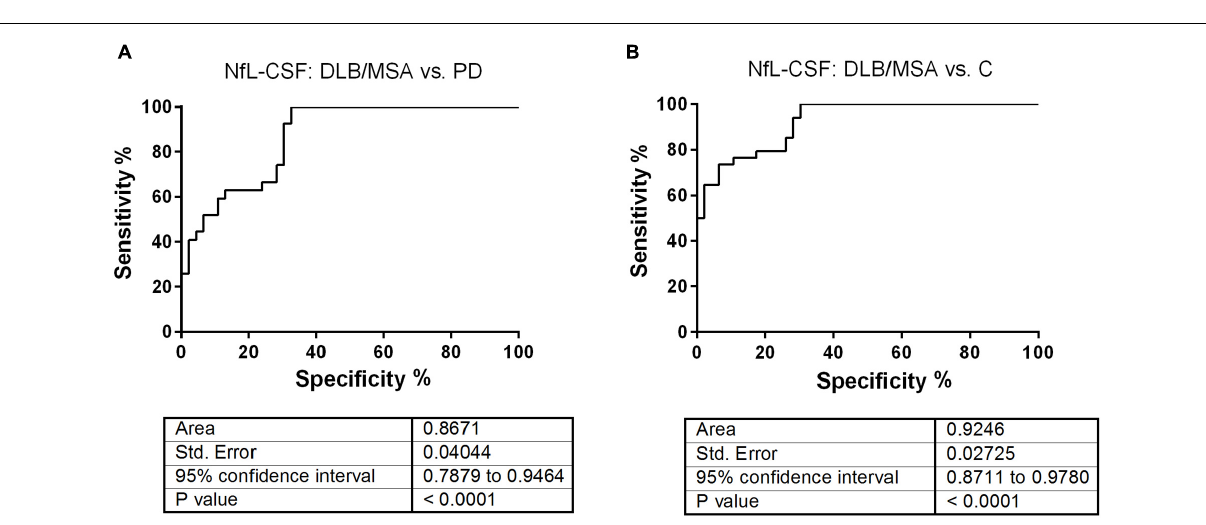
Frontiers in Aging Neuroscience |